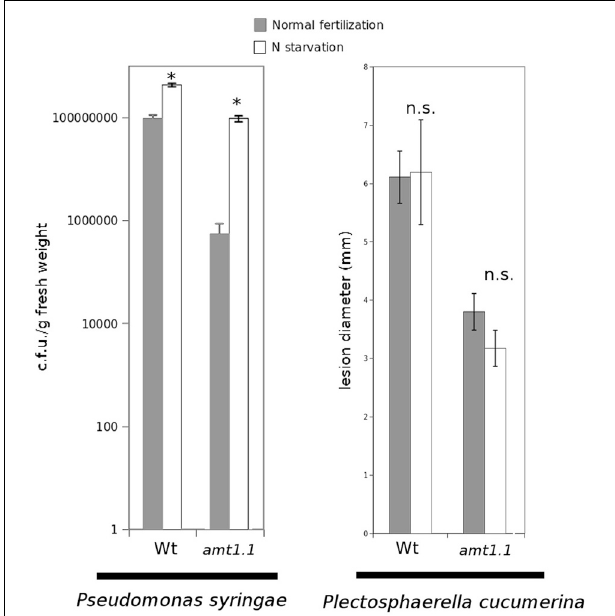
FIGURE 3 | P. syringae proliferation and lesion diameter cause by P. cucumerina in Col3-gl1 and amt1.1 plants fertilized normally (Normal fertilization) along 5 weeks and exposed to N starvation 2 days before inoculation (N starvation). Hydroponically growing plants were challenge-inoculated either with a bacterial suspension of P. syringae at 2 . 5 × 10 5 c.f.u./ml or with a drop of 1 × 10 5 spores × mL − 1 of PcBMM. Data represent the average of three independent experiments ( n = 3). The values presented are means of infected plants ( ± SD). Asterisk indicates statistically significant differences (LSD test; p < 0 .